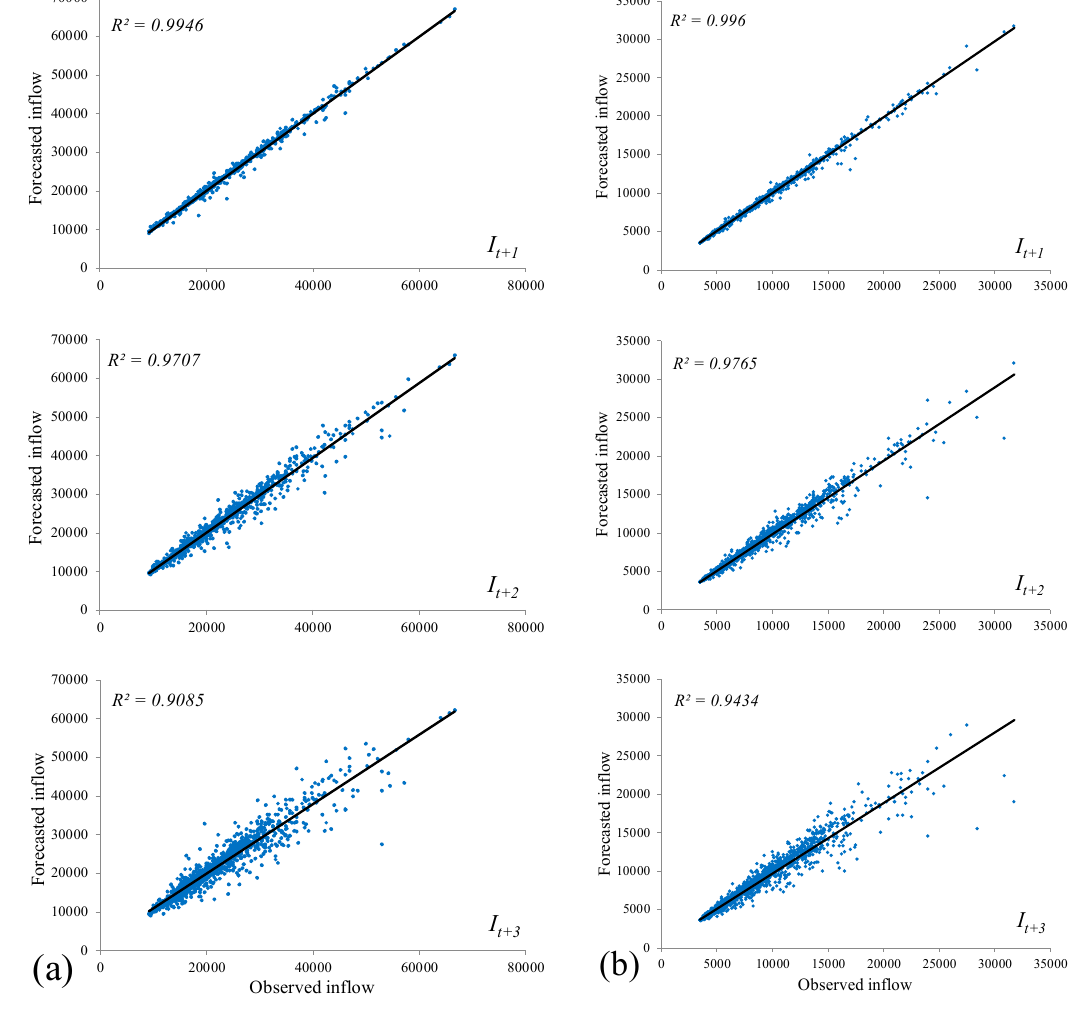
Figure 9. Scatter-plots of observed and forecasted inflows ( a ) flood season ( b ) non-flood season.